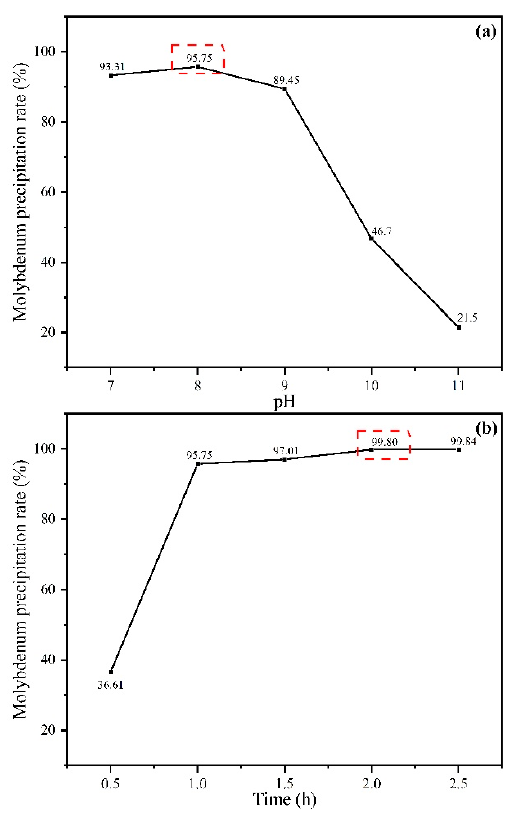
Figure 13. Effects of pH ( a ) and time ( b ) on the molybdenum precipitation rate.